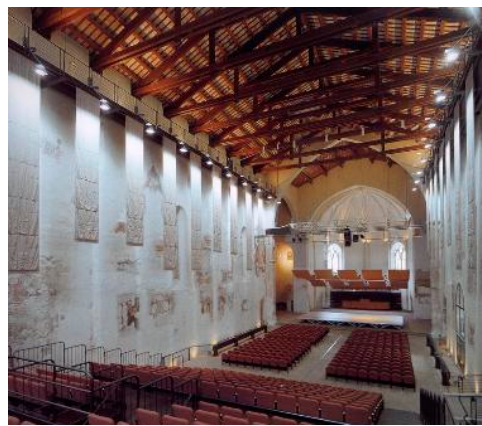
Figure 2. Church of S. Dominic of Foligno.